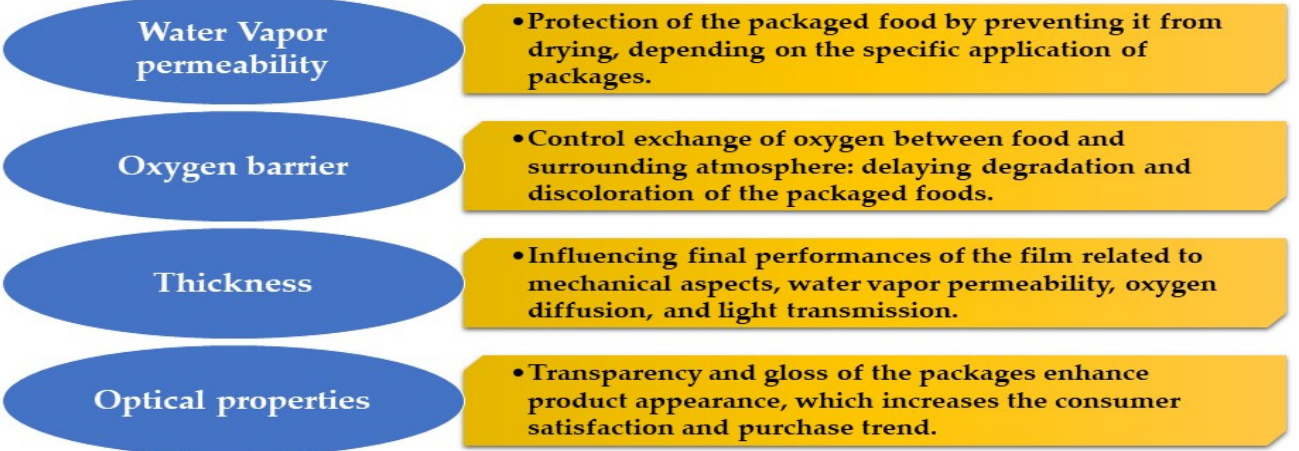
Figure 3. Technological properties of marine biopolymer-based packaging materials with specific functions.